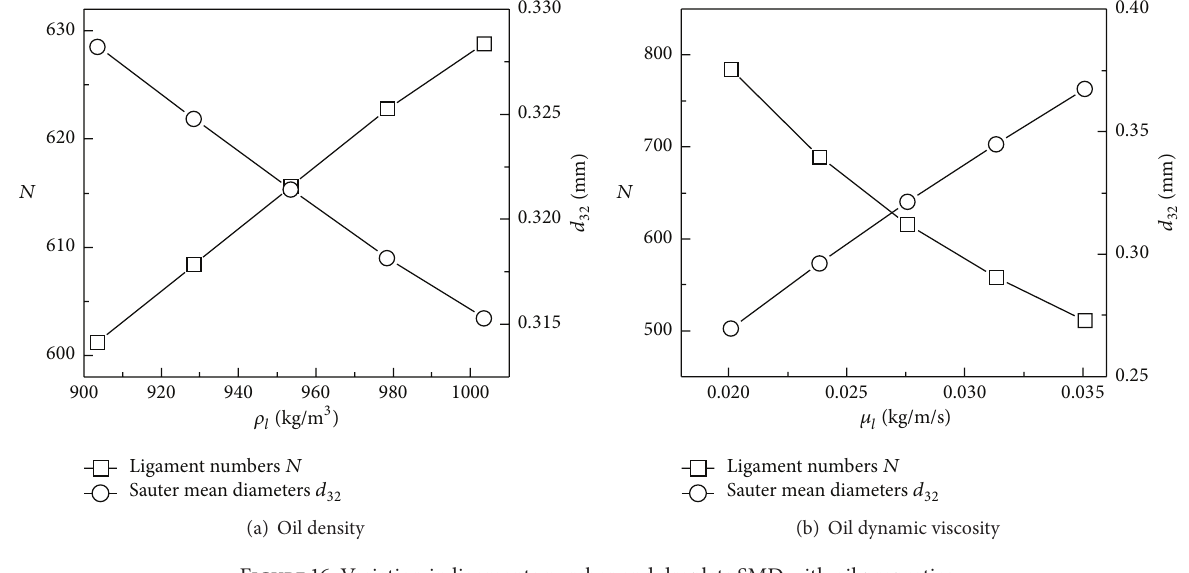
Figure 16: Variation in ligaments number and droplets SMD with oil properties.